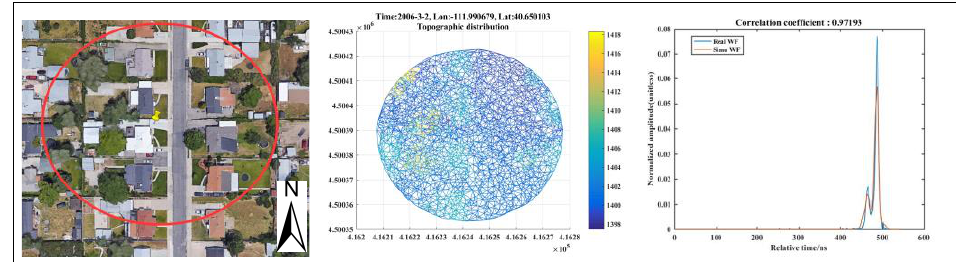
± Figure 4. Examples of experimental